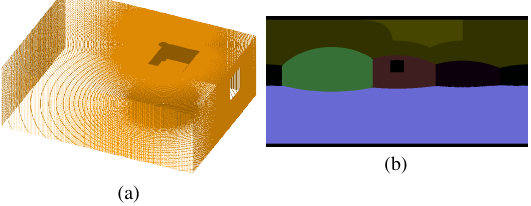
Figure 1. Simulated capture of a room by a LiDAR laser scanner. (a) Point cloud. (b) { ϕ, θ }